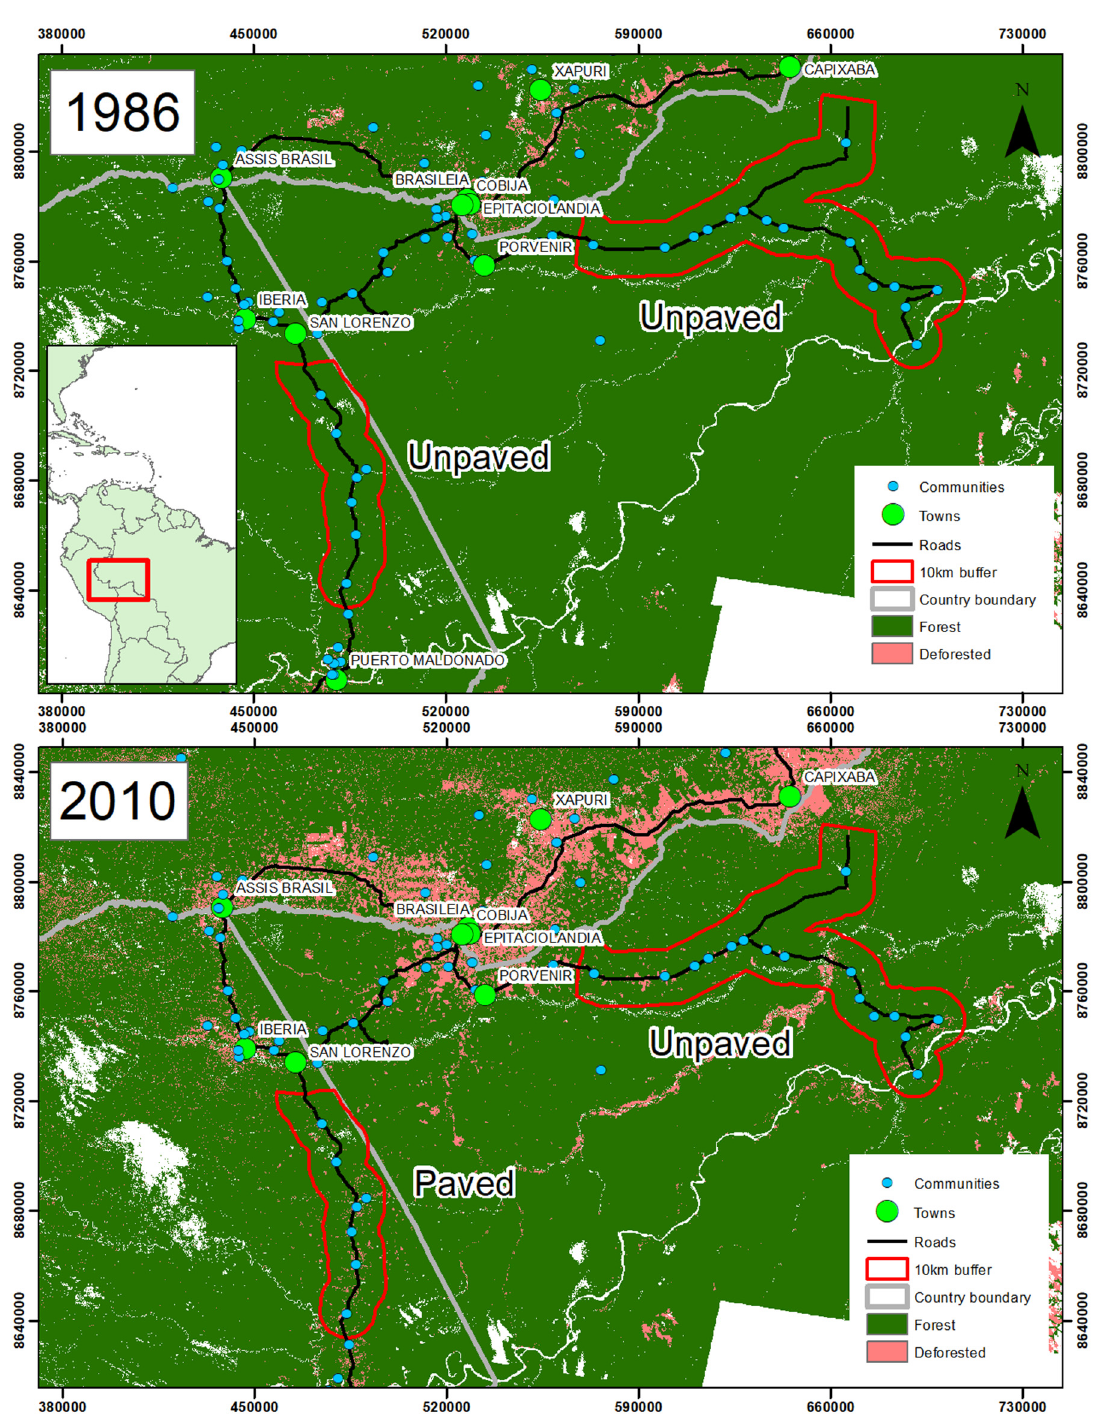
Figure 2. Map of the selected road segments, superimposed on deforestation maps at the beginning and end of the study period (1986 and 2010, respectively). Inset displays the approximate location of the Brazil, Peru, and Bolivia tri-national region. Tick marks show WGS84 UTM Zone 19S projected coordinates. White areas in the background correspond to clouds, water, or shadows that were removed.